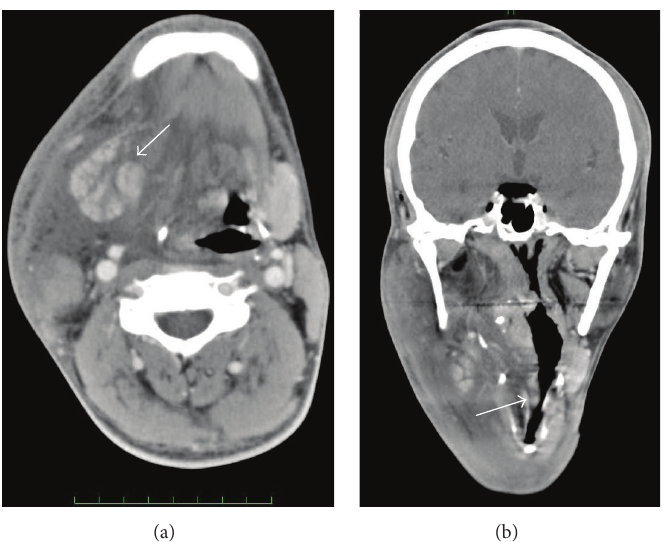
Figure 4: (a) Axial image of computed tomography 7 hours after operation. Edematous tissue around the right submandibular gland (arrow) was found to have increased, and it extended to the right parotid region. (b) Coronal image of computed tomography 7 hours after operation. The glandular swelling was found to be displacing the larynx